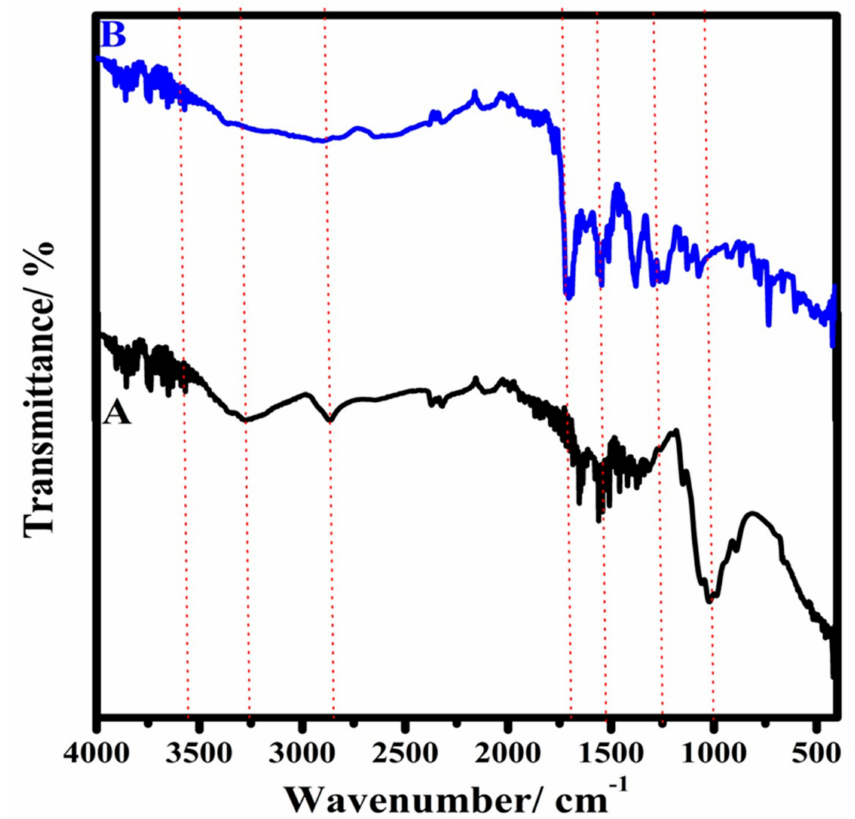
Figure 1. FTIR spectra of ( A ) CH and ( B ) CH/Zn@H 3